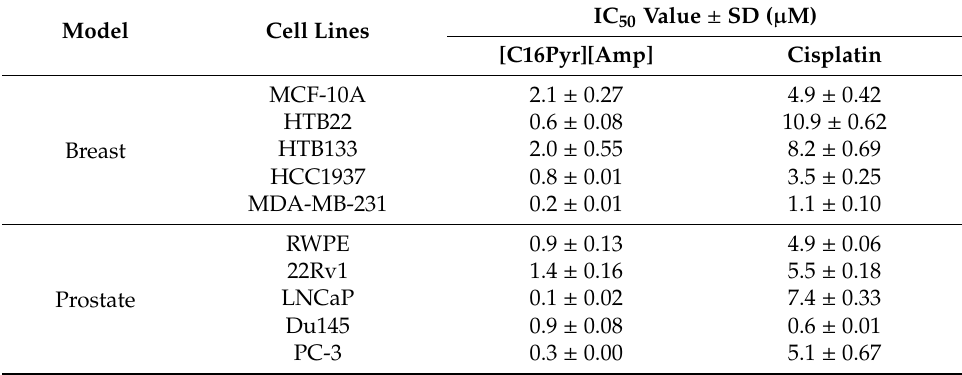
Table 1. Half-maximal inhibitory concentration (IC 50 ) values of [C16Pyr][Amp] and cisplatin for di ff erent breast and prostate cell lines. All data are presented as mean of three independent experiments ± standard deviation